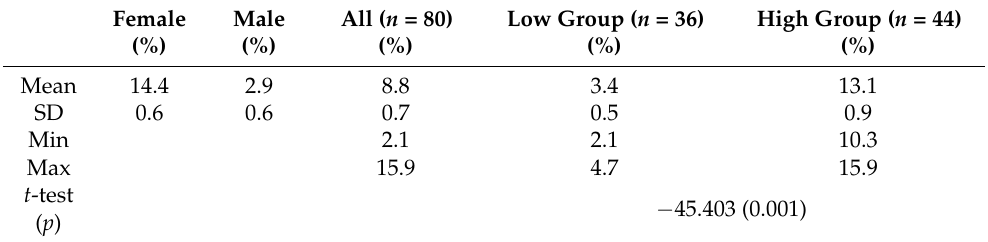
Figure 1. Frequency distribution of average amylose content of each line in maize F 7:8 RIL population. Table 1. Results of amylose content evaluation for the two parental lines, all RIL populations, and the low and high groups.